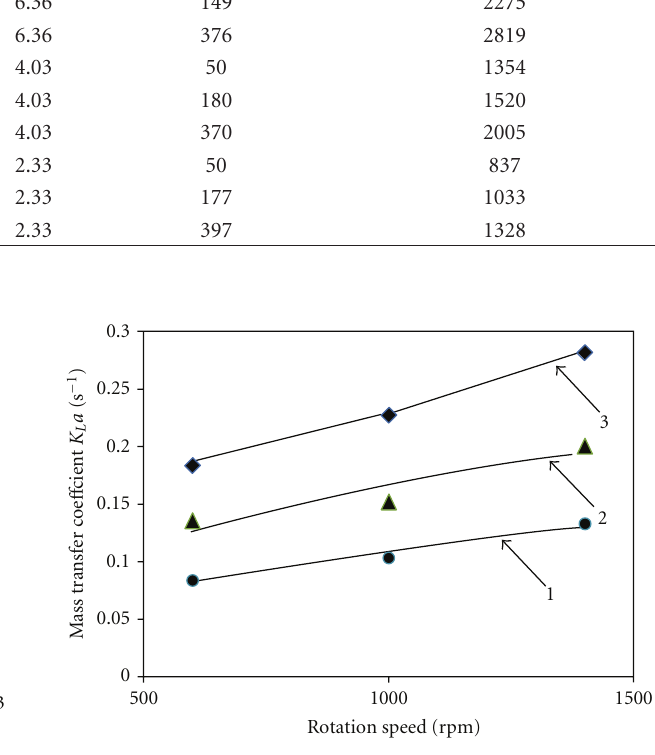
Figure 9: Variation of mass transfer coe ffi cient with disk rota- tion speed; Prediction (correlation using CFD data); Line 1: 110 mL/min; Line 2: 190mL/min; Line 3: 300mL/min, • EXPT 110 mL/min, (cid:2) EXPT 190 mL/min, (cid:3) EXPT 300 mL/min.